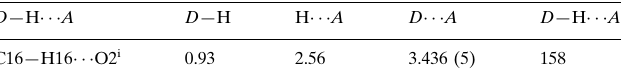
Hydrogen-bond geometry (A˚ , (cid:1)